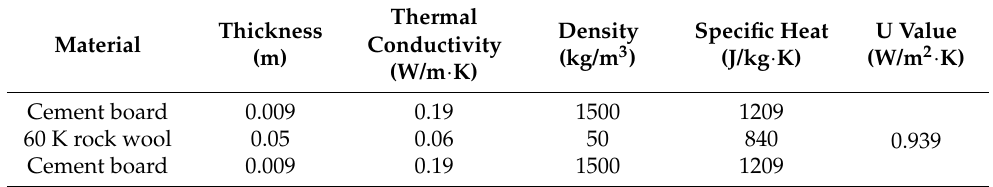
Table 2. Material setting of exterior wall, roof, and floor construction.